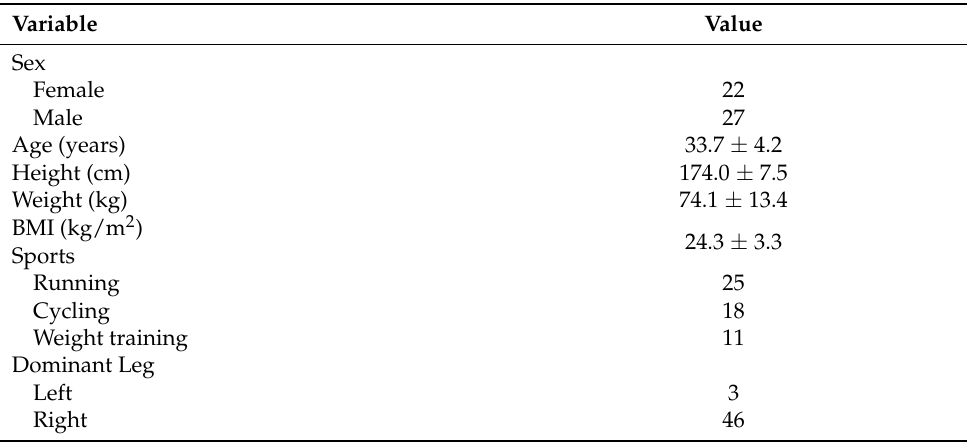
Table 1. Subject demographic and anthropometric characteristics. Most performed sports were queried (multiple responses were possible).